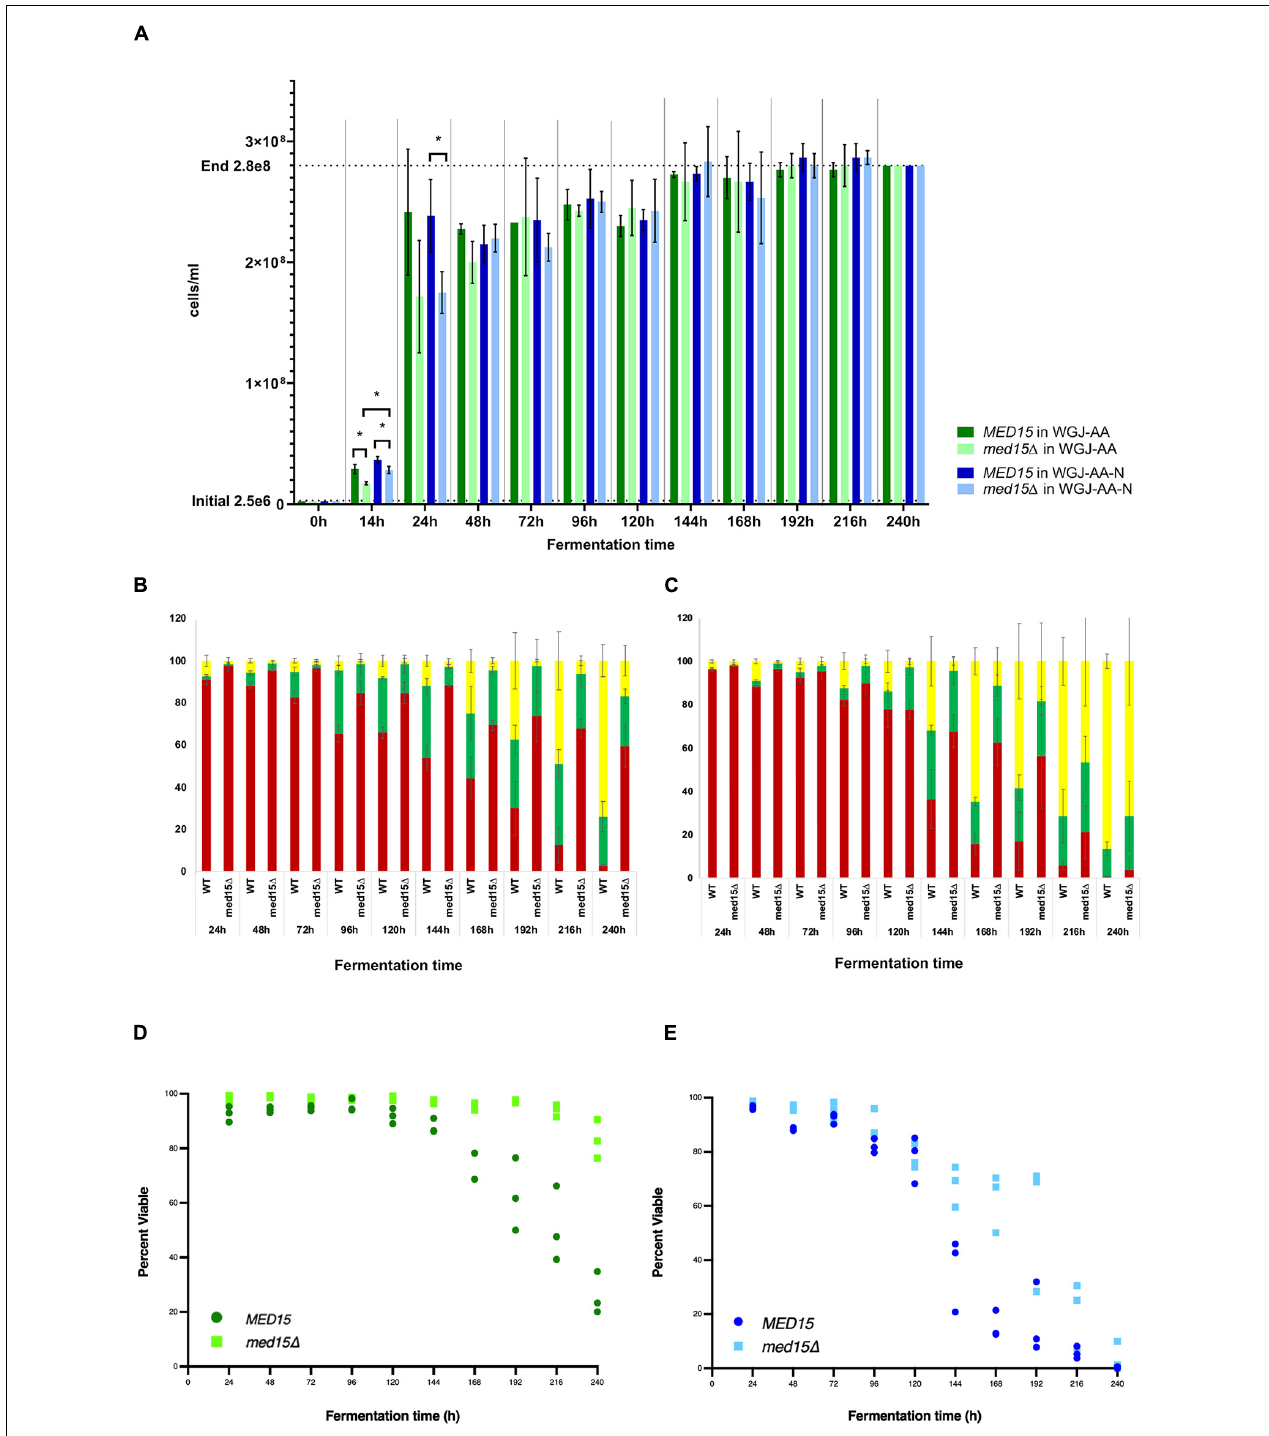
FIGURE 2 | MED15 mutants are less sensitive to late fermentation stresses. (A) Cell number was determined microscopically using a hemocytometer for the WT and med15 (cid:49) mutant in WGJ-AA and WGJ-AA-N media. (B,C) Results of FUN-1 staining with individual tallies of red (metabolically active), green (metabolically inactive), and yellow (permeabilized, dead) cells at each time point in WGJ-AA (B) and WGJ-AA-N (C) media. (D,E) Plots of viable cells (red + green) at times during fermentation in WGJ-AA (D) and WGJ-AA-N (E) . 3 biological replicates (transformants) are plotted for each time point for each genotype.